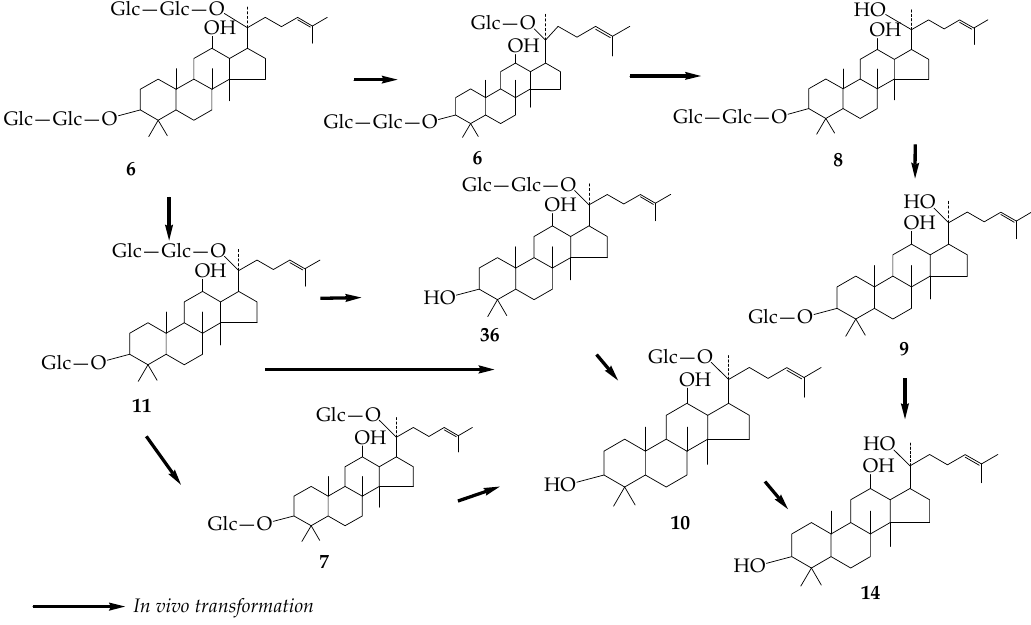
Figure 7. Metabolic pathway of Gyp- Ⅲ in vivo .